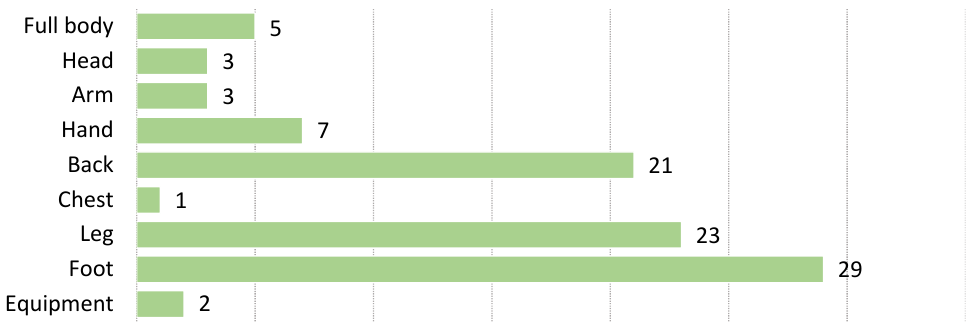
Figure 8. Wearable sensor placement on the user’s body or equipment. Multiple sensors were used in the studies.